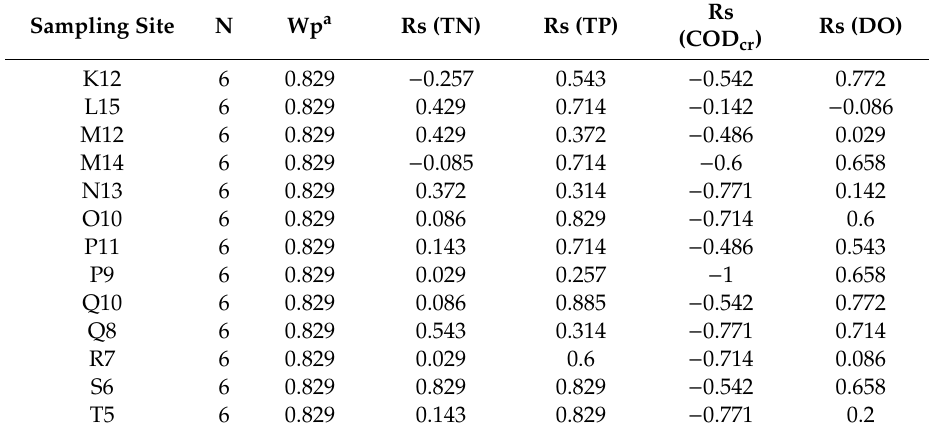
Table 3. Temporal variation trends calculated by the Daniel trend test method at the 13 sampling sites.